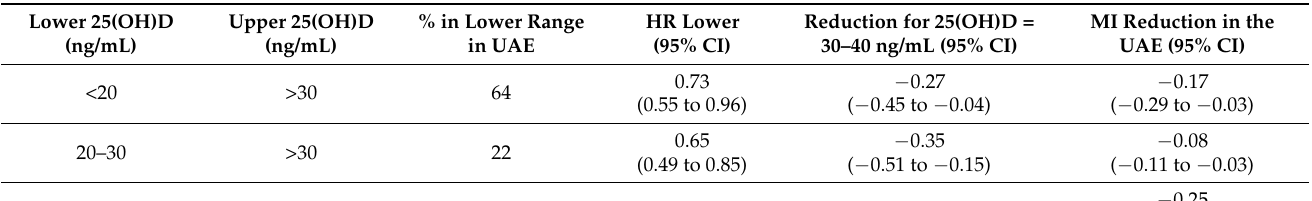
Table 2. Estimate of reduction in MI incidence rate in the UAE by raising minimum 25(OH)D concentration to 30 ng/mL using 25(OH)D data from UAE [85] and results from a U.S. veterans study [80].